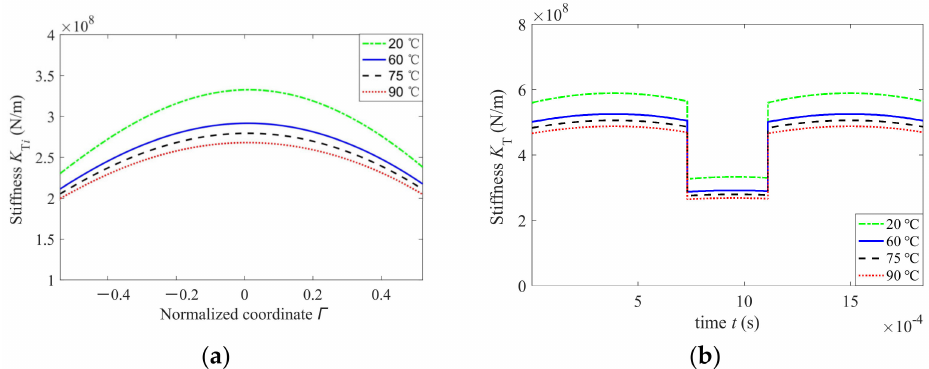
Figure 8. Gear thermal stiffness at different temperatures. ( a ) Thermal mesh stiffness of a single tooth pair; ( b ) Time-varying gear thermal mesh